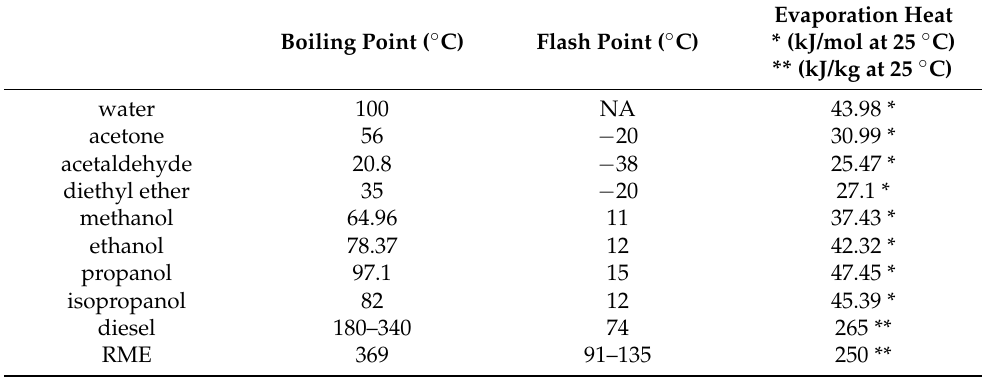
Table 2. Numerical values of some important physical properties of the different oxygenates and fuels. NA: Not applicable. (Data obtained from refs.